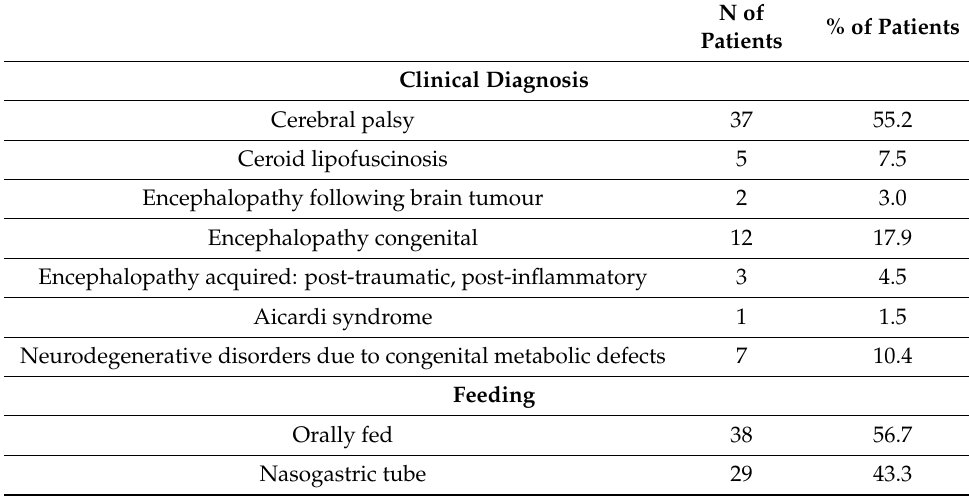
Table 1. Demographic characteristic of the study